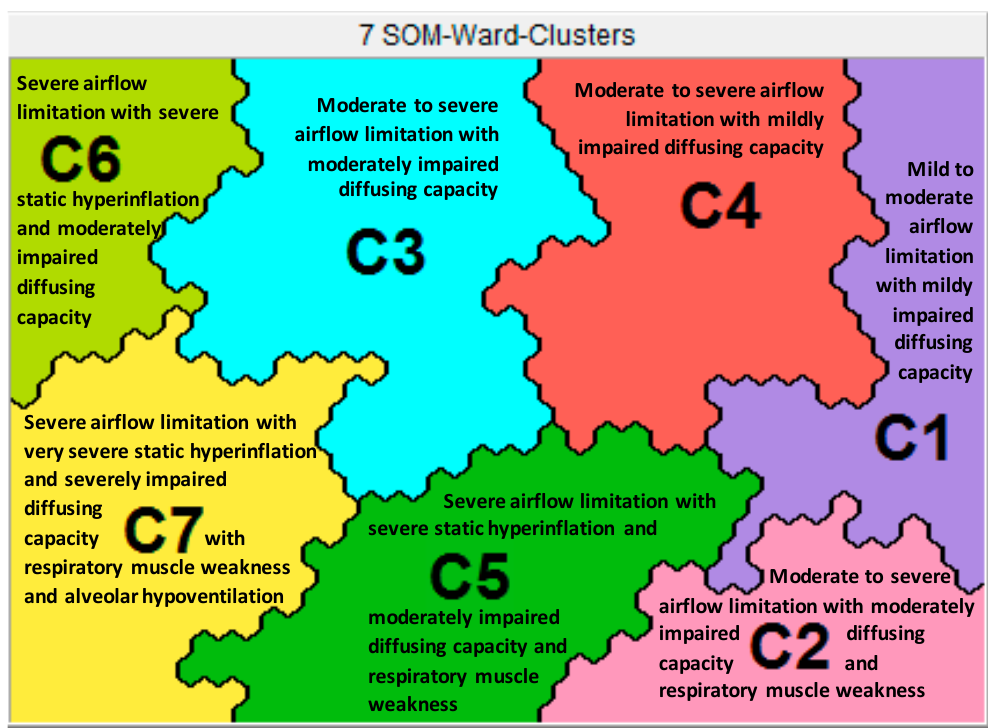
Figure 2. Seven different clusters of patients with COPD based on differing respiratory physiome. This figure was published in Augustin et al. [11] Legend Figure 2: The seven lung function clusters in chronic obstructive pulmonary disease (COPD) using Viscovery (Viscovery Software GmbH, Vienna, Austria). Viscovery program placed all subjects on a specific position on the map based on their profile of a comprehensive lung function assessment. Subjects with similar lung function are closer together on the map and vice versa. By drawing lines on the map, the Viscovery program could identify seven different clusters of patients with COPD with a significantly different respiratory physiome (95% confidence interval).